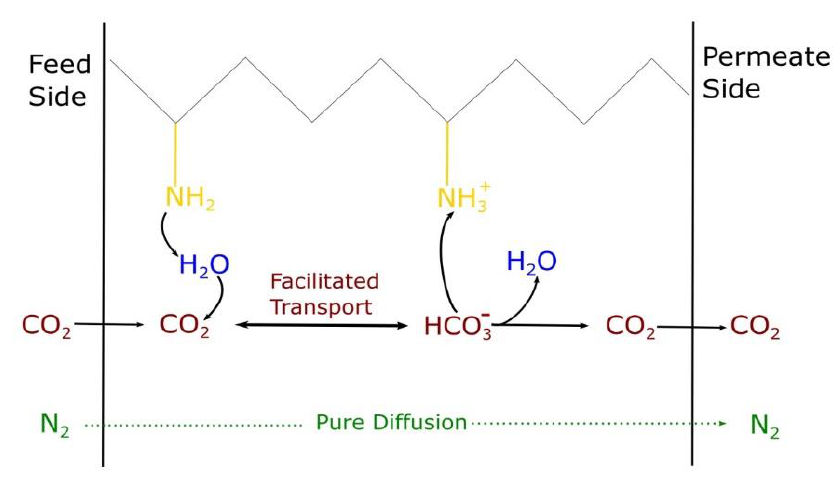
Figure 1. Example of Facilitated Transport Membranes (FTM) mechanism.